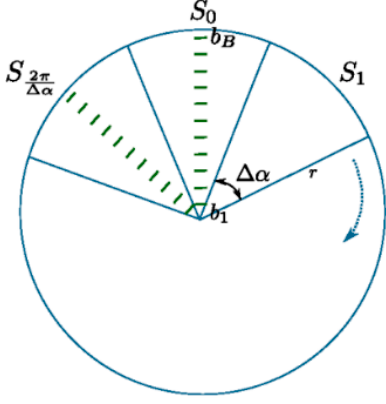
Figure 4. Partitioning the 3D space into segments of equal size.